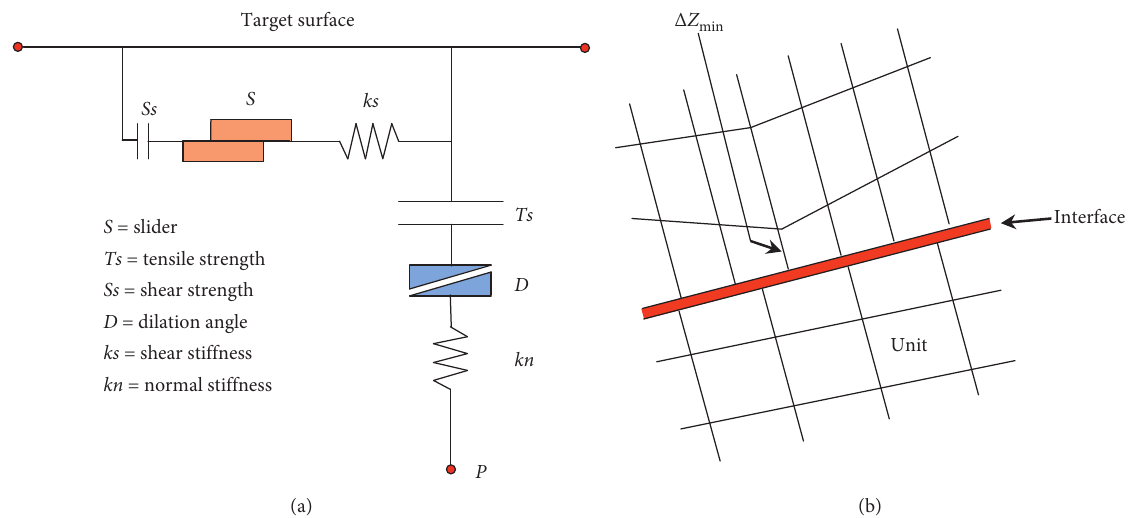
Figure 5: Details of the numerical model. (a) Constitutive model of interface between the fault zone and rock mass. (b) The minimum size in normal direction at the